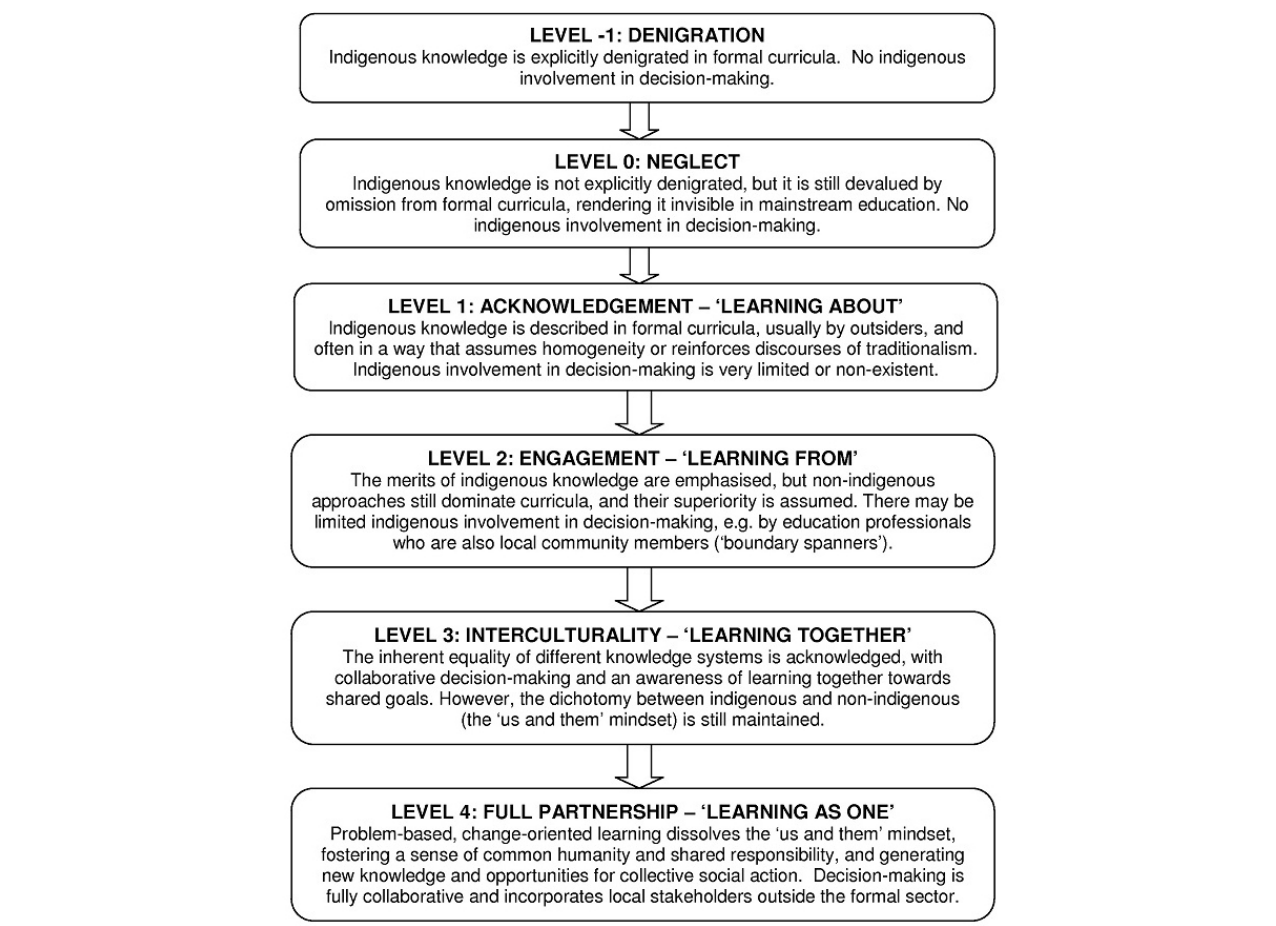
Fig. 1. A ladder of indigenous participation in intercultural